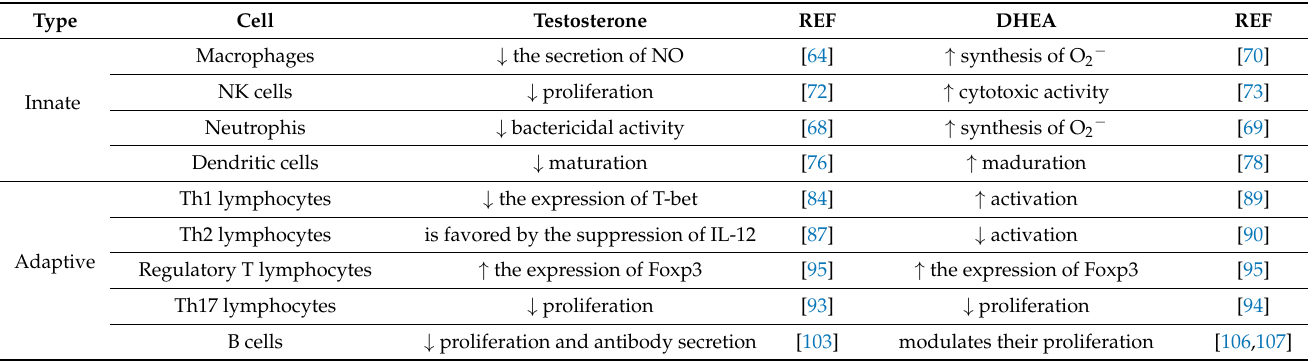
Table 1. Effect of testosterone and DHEA on innate and adaptive immune response